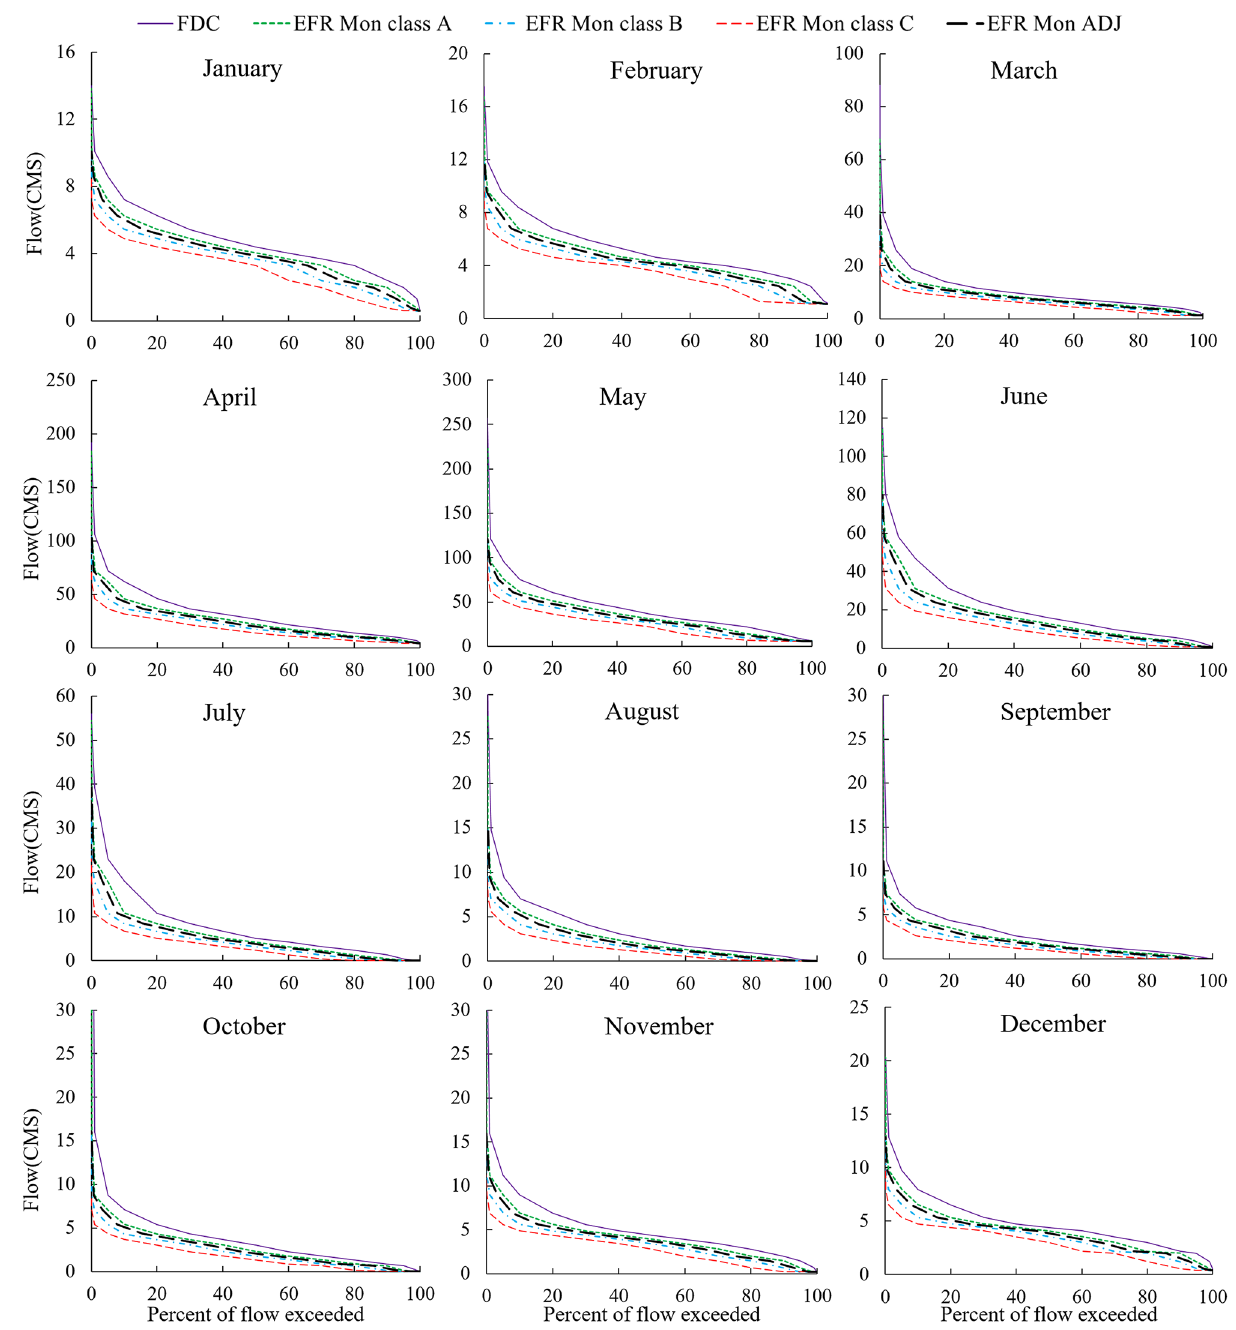
Figure 6. Comparison of monthly FDCs for different EMCs with the shifted FDC relying on the adjusted EFR of the lake at the Tapik Station, Nazlu